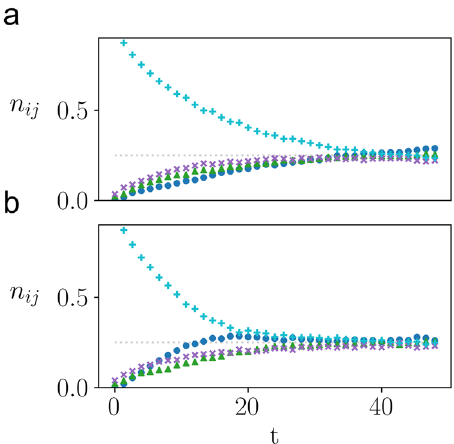
Fig. 6 Demonstration of a 11 j i ! 00 j i eigenstate transition in the simulated time evolution of a correlated two-qubit system. Simulated evolution for time t on ibmq_bogota where the time step τ = 1/3, and the Hamiltonian is composed of three variable frequencies ω i , ^ H ¼ ω 1 σ 1 z þ ω σ 2 þ ω σ 1 σ 2 σ i i is given by Eq. (2). a Using ω = 1, z z z , where z acting on qubit 3 2 3 and ω 1 ; ω 2 ¼ 1 , the system demonstrates expected exponential decay to the 2 thermally mixed state. b With ω 3 = 1 and frequencies, ω 1 ¼ 1 and ω 2 ¼ (cid:2) 1 , 10 20 despite the quick decay we see a correlated two-qubit transition between the 11 j i and 00 j i eigenstates where the other populations match the decay seen in ( a ). The dotted grey line represents the ideal fully mixed population for each eigenstate n ij ¼ 1 . The simulated populations are represented as n 00 : ○ (blue), 4 n △ (green), n n + 01 : 10 : × (purple), and 11 :